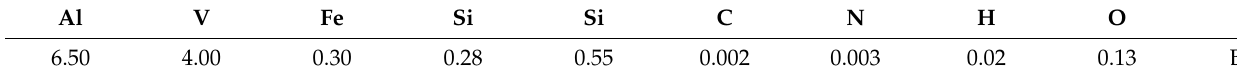
Table 1. Chemical composition of Ti-6Al-4V titanium alloy (in weight, wt %).